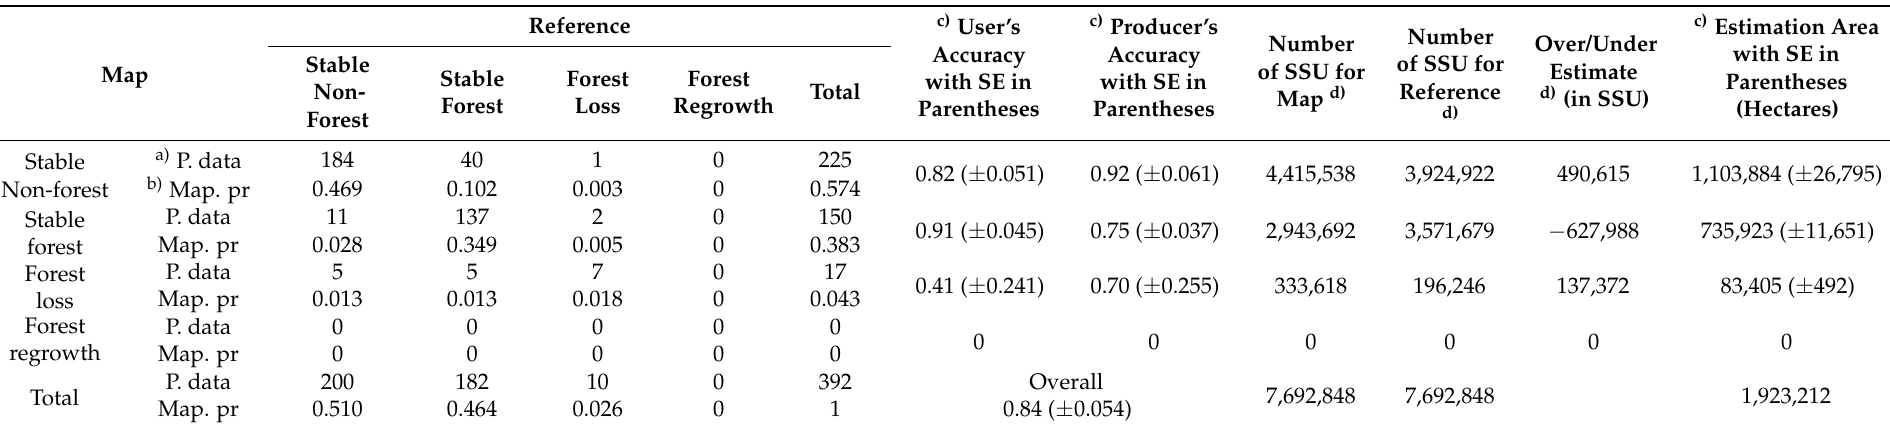
Table A6. Description of population data and map proportion area confusion matrix for the visual interpretation of land cover change map in 2012–2018.